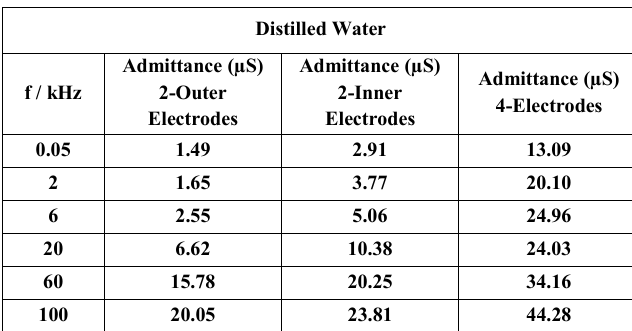
Table (4): Comparing the values of impedance and admittance for the three experimental setups (4, 2-inner, and 2-outer electrodes) at all frequencies of distilled water.